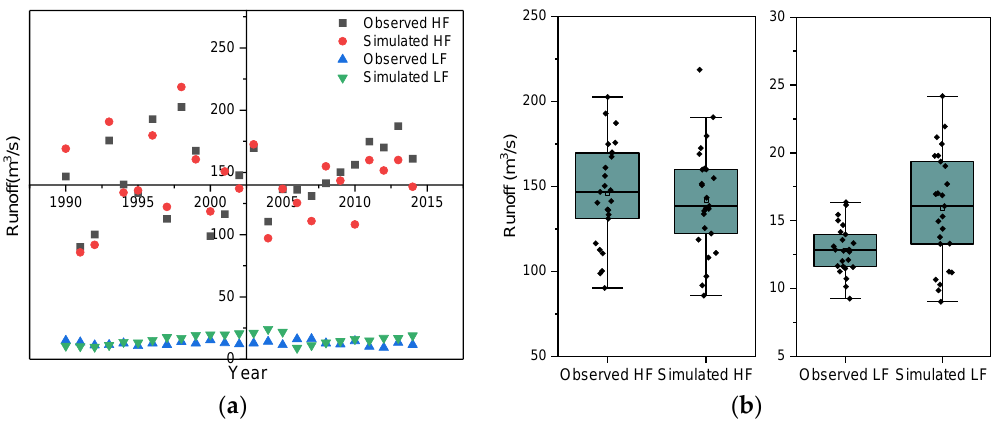
Figure 8. Comparisons of observed and simulated high flows and low flows. (a) is a scatter plot, and (b) is a box plot.